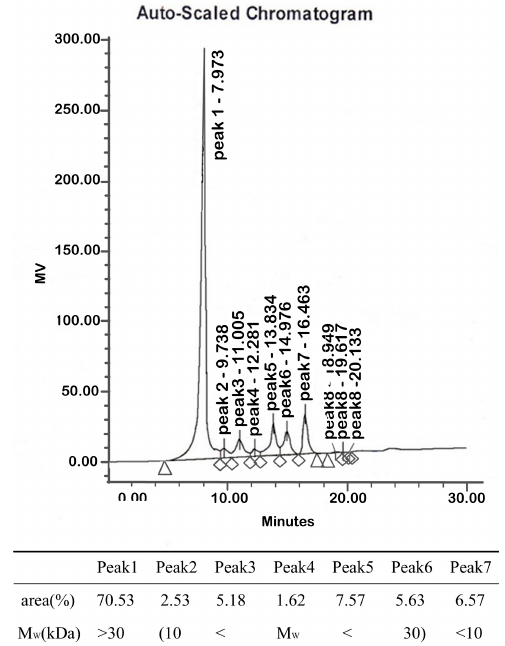
Figure 2. Molecular weight of LBP. Peak 1 has a molecular weight higher than 30 kDa. The molecular weights of peak 2 to peak 6 lie between 10 kDa to 30 kDa. Peak 7 has a molecular weight lower than 10 kDa.